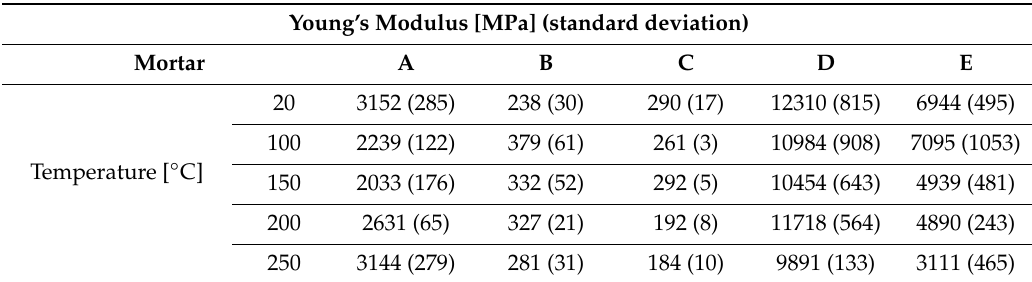
Table 4. Young’s modulus average vs. exposure temperature.